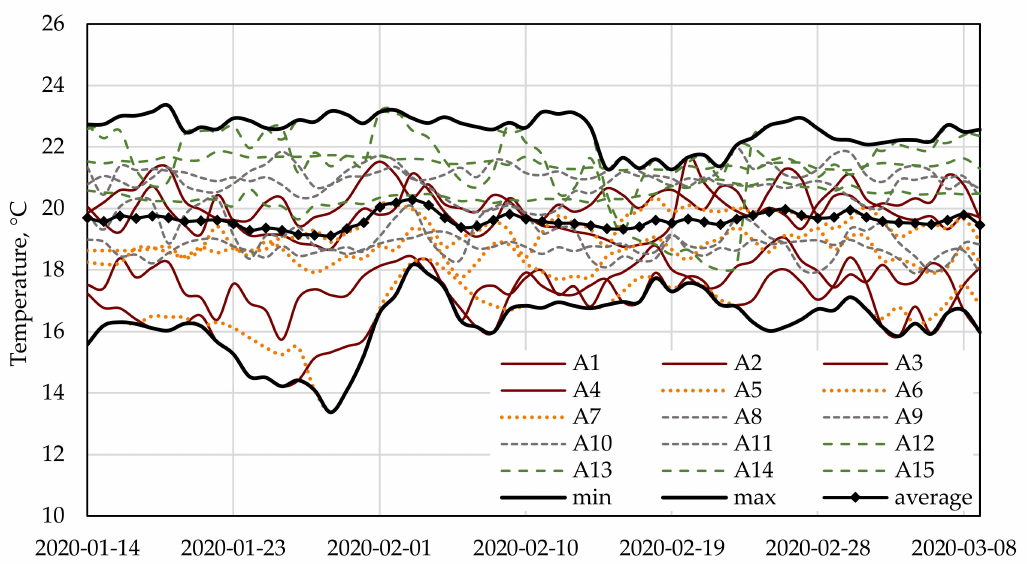
Figure 3. Average indoor air temperatures in apartments during the tests: 14 January to 9 March